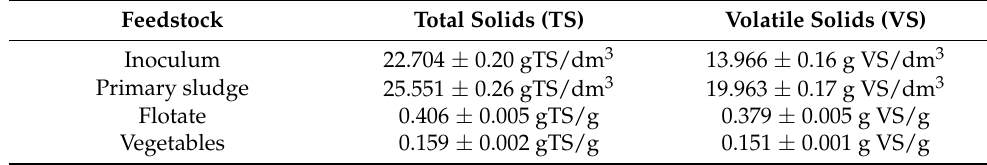
Table 2. Feedstock